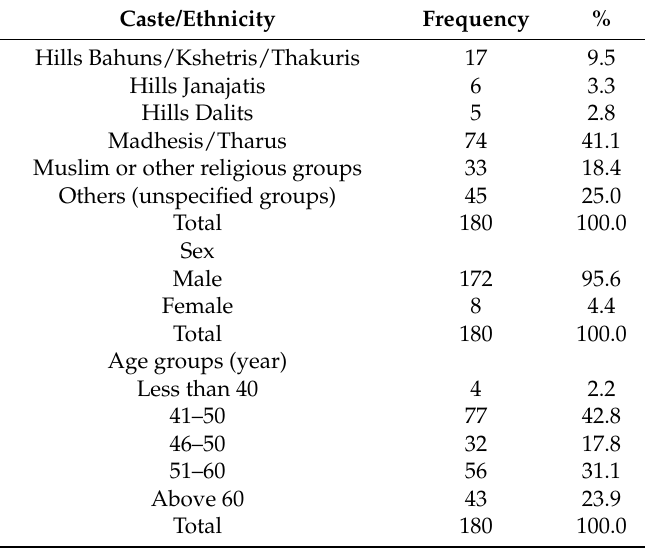
Table 1. Distribution of respondents by caste/ethnicity, sex, and age